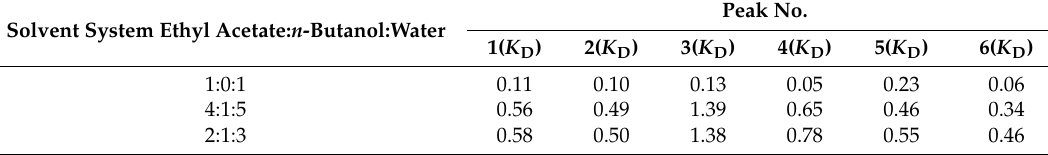
Table 1. Partition coefficients ( K D ) of the target compounds in different solvent systems. Solvent System Ethyl Acetate: n -Butanol:Water